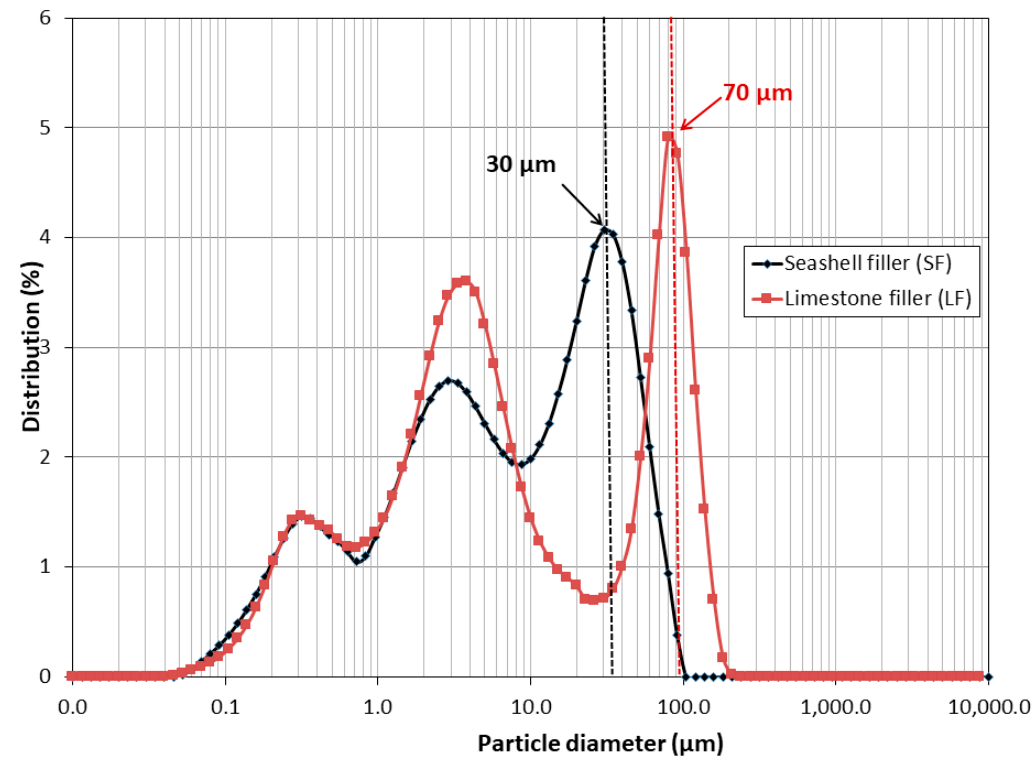
Figure 6. Particle size distribution of Seashell filler (SF) and Limestone filler